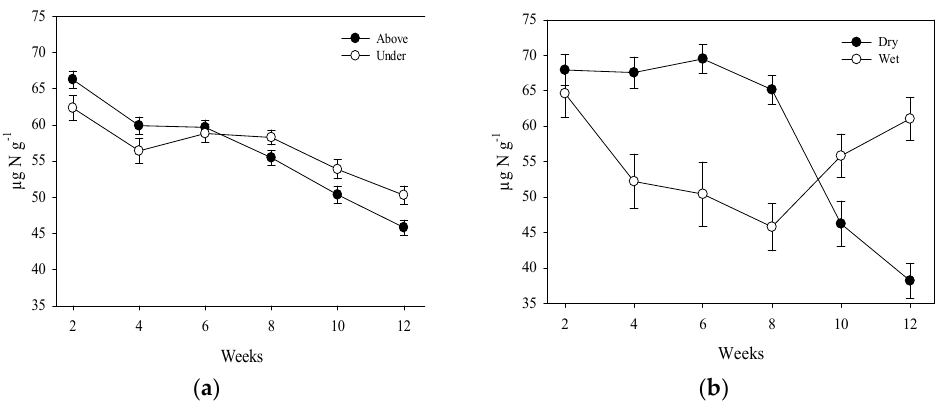
Figure 2. Mean average N content interaction of ( a ) time of sampling by bag position and ( b ) time of sampling by seasons for both legumes in an Oxisol. Vertical lines represent the standard errors.